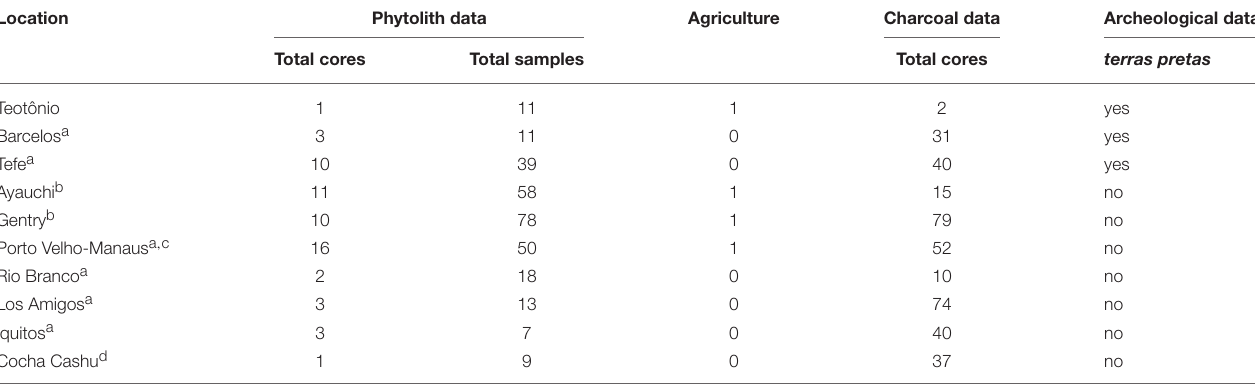
TABLE 1 | Sampling effort for each region included in the analysis. Location Phytolith data Agriculture Charcoal data Archeological